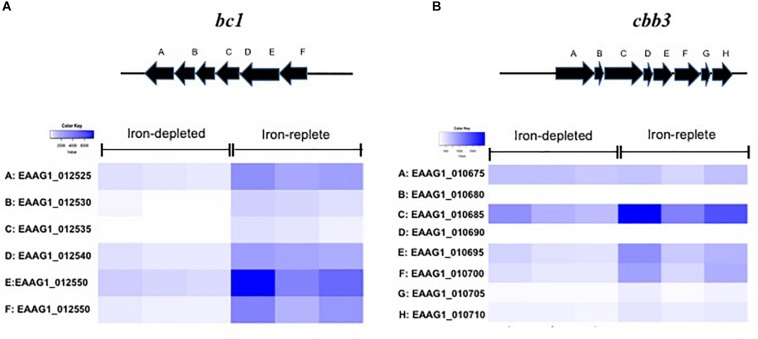
Genes encoding respiratory chain complex bc1 and cbb3 in response to iron availability. (A) The scheme of genome organization in the bc1 operon, with heat map of the cytochrome bc1 gene expression under the low iron and high iron conditions. (B) The scheme of genome organization in the cbb3 operon, with heat map of the cytochrome cbb3 gene expression under the low iron and high iron conditions.